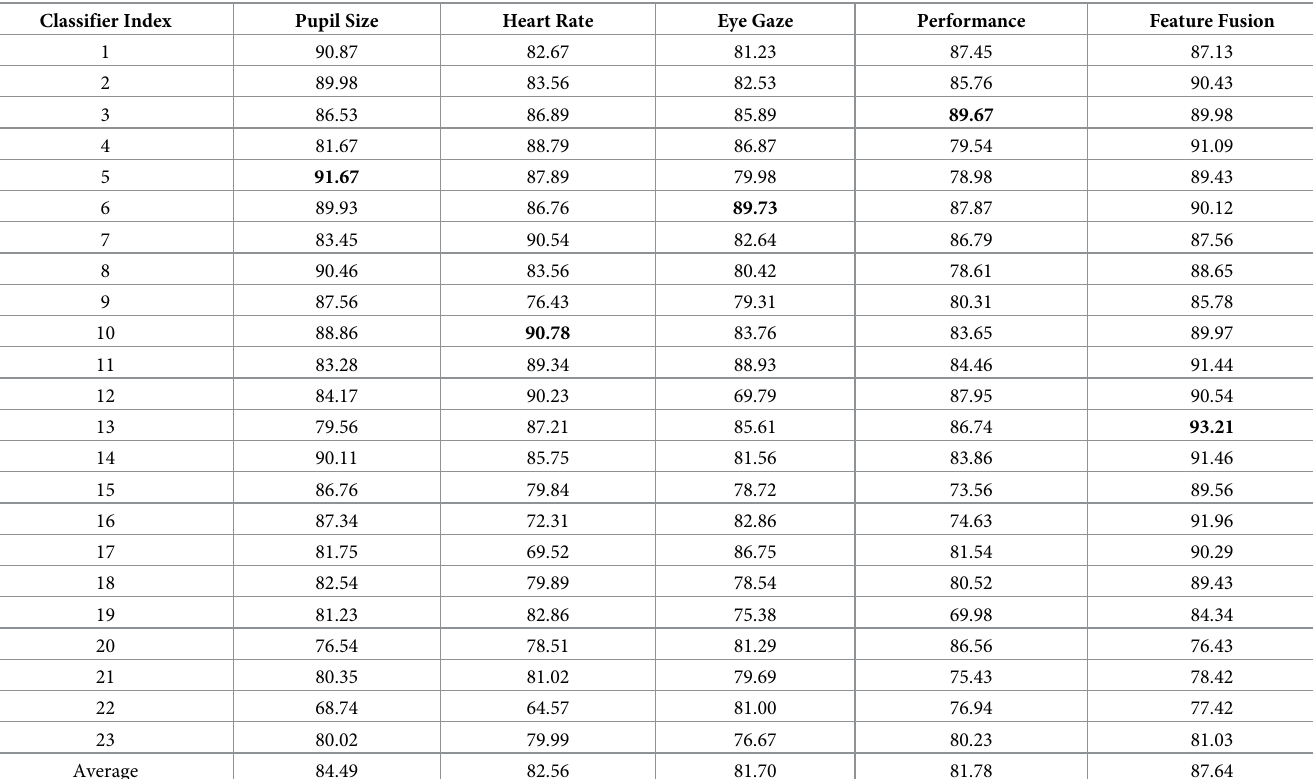
Table 6. Feature-level fusion vs. single-modality classifiers